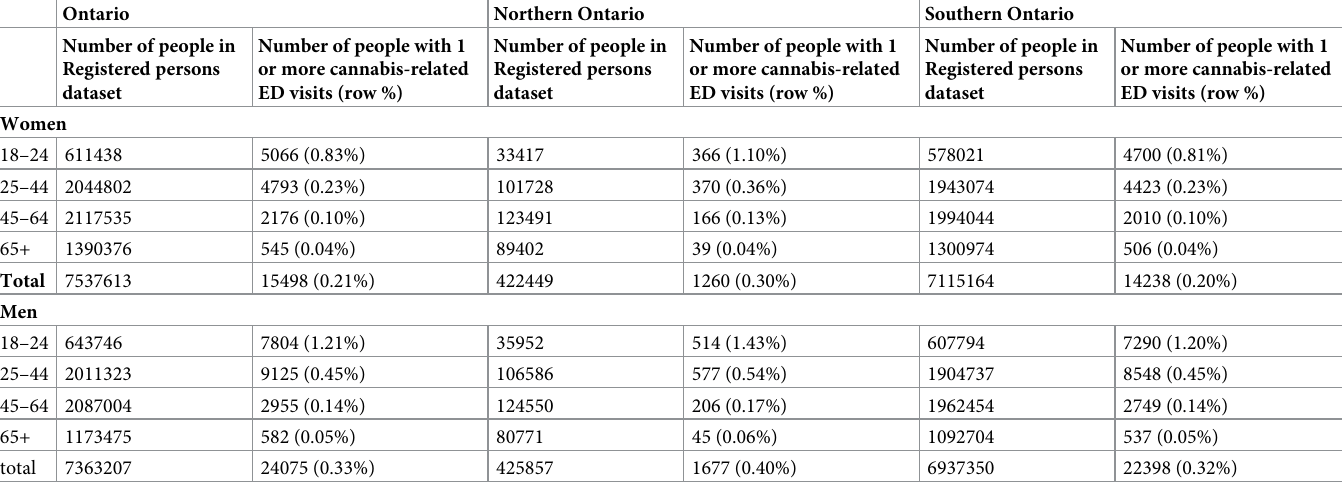
Table 1. Cohort characteristics and prevalence of cannabis-related ED visits over the study period (n = 14,900,820).